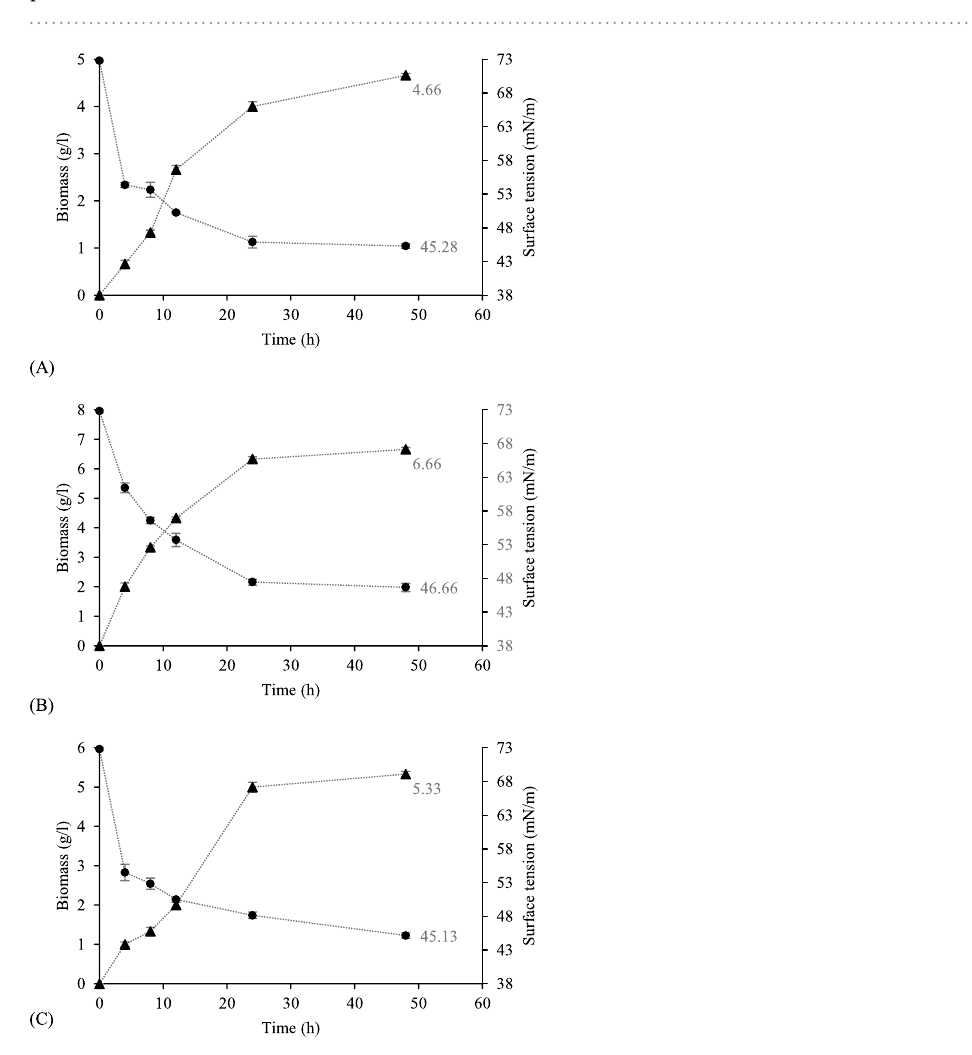
Figure 1. ST variation (mN/m) of BS solutions and biomass concentrations (g/l) obtained from fermentations carried out in the bioreactor using MRS-Lac ( A ) date syrup ( B ) and molasses ( C ) media. Results represent the average of three independent experiments. Biomass (.. ▲ ..); ST (.. •